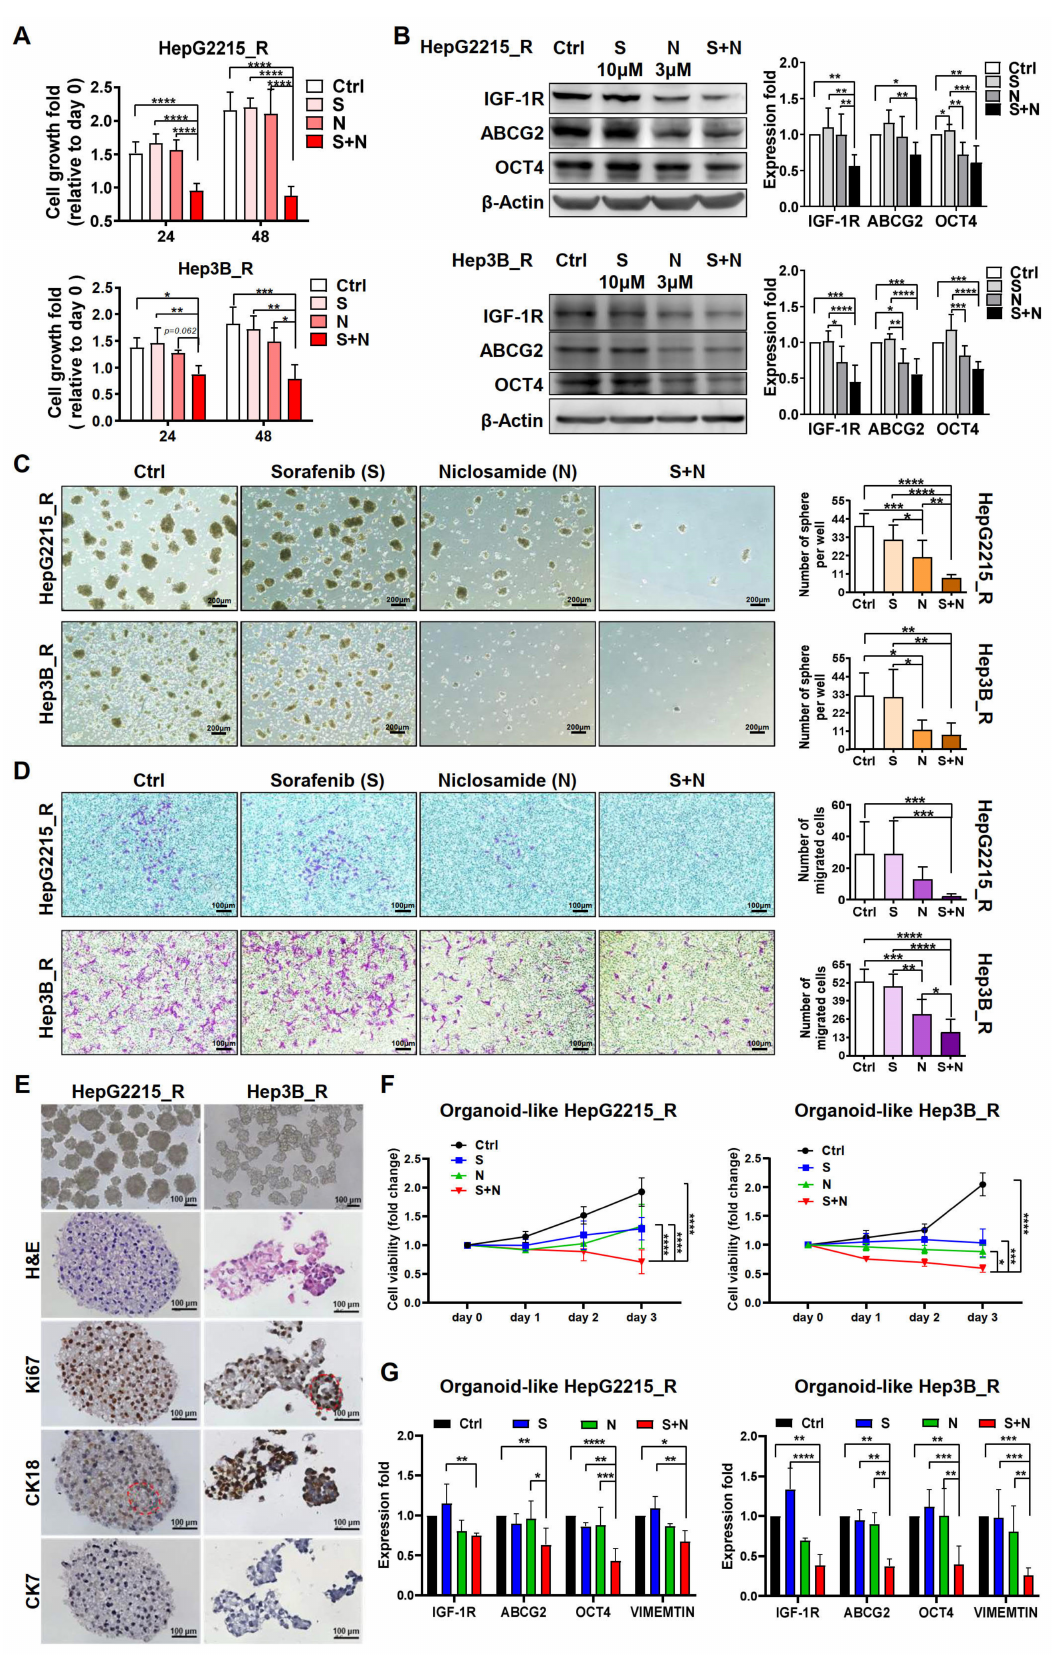
Figure 2. The combination of niclosamide and sorafenib enhances cell death and reduces the activity of stemness-related properties in sorafenib-resistant HCC cells and their organoids. ( A ) Cell